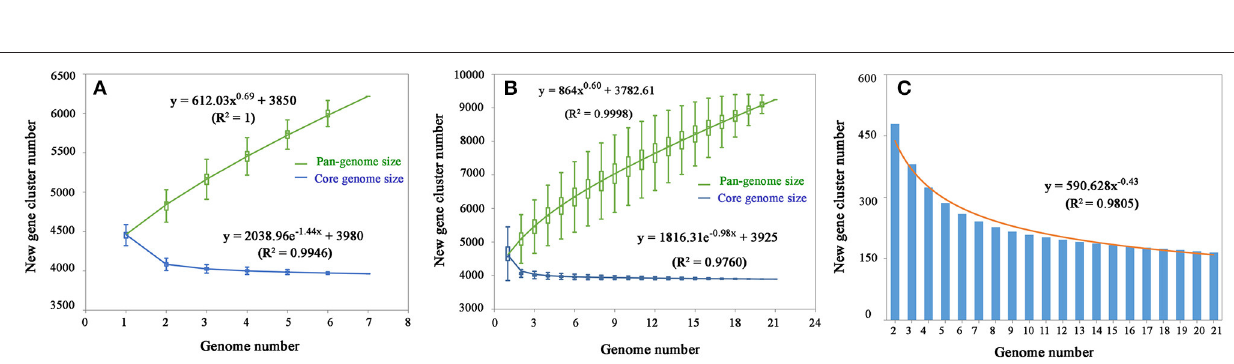
FIGURE 2 | The pan-genome profiles of the seven V. alginolyticus strains isolated in this study, together with other 14 available genomes of V. alginolyticus strains.